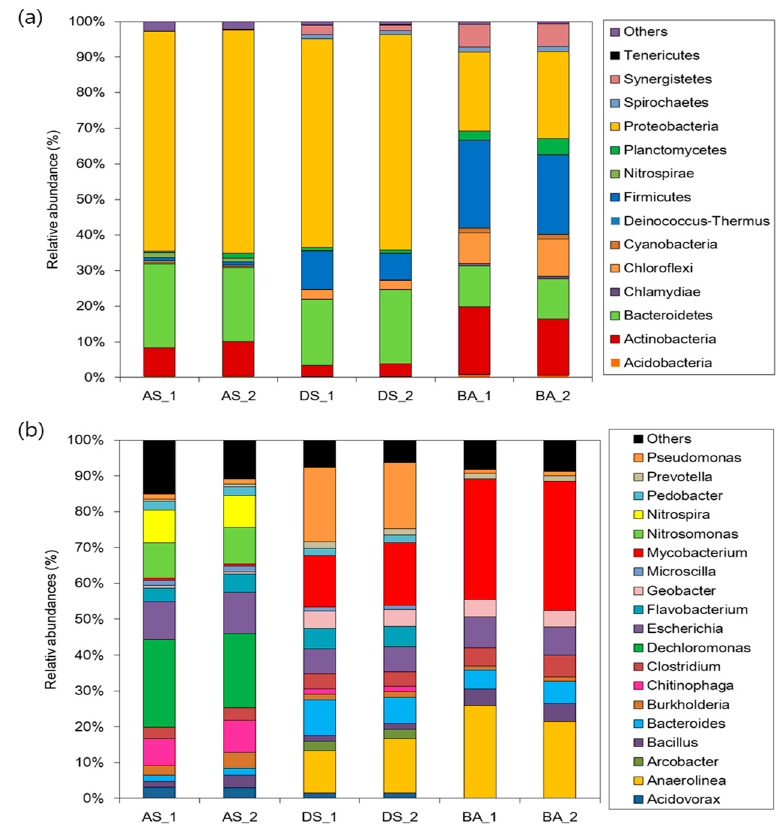
Figure 3. The relative abundances of the major detected phyla ( a ) and genera ( b ) in the AS, DS, and BA samples. AS1, DS1, and BA1 indicate January samples in 2015, and AS2, DS2, and BA2 indicate November samples in 2015.